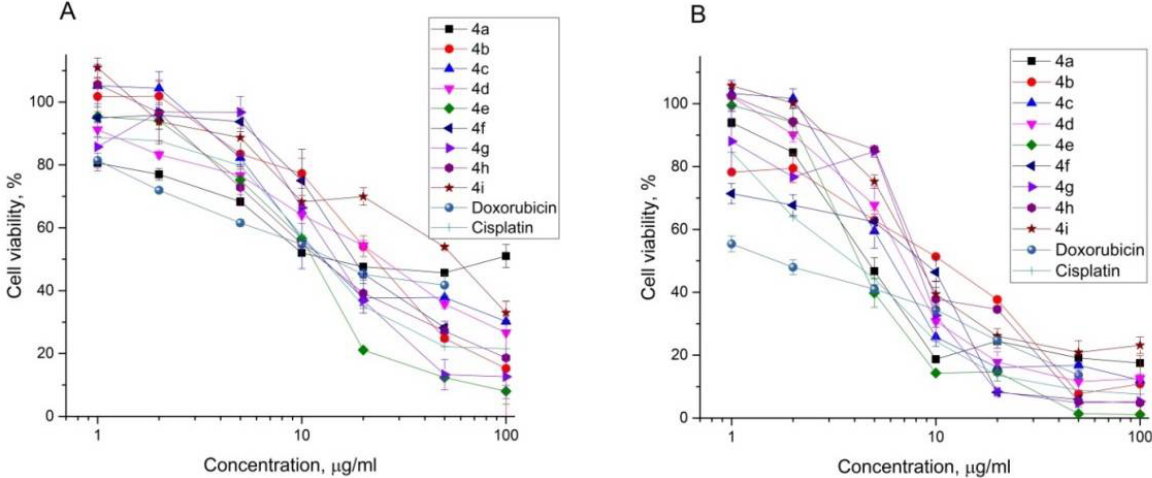
Figure 5. Cytotoxicity of 3-azaspiro[bicyclo[3.1.0]hexane-2,5′-pyrimidines] 4a–i against Vero cell line for 24 h ( A ) and 72 h ( B ).